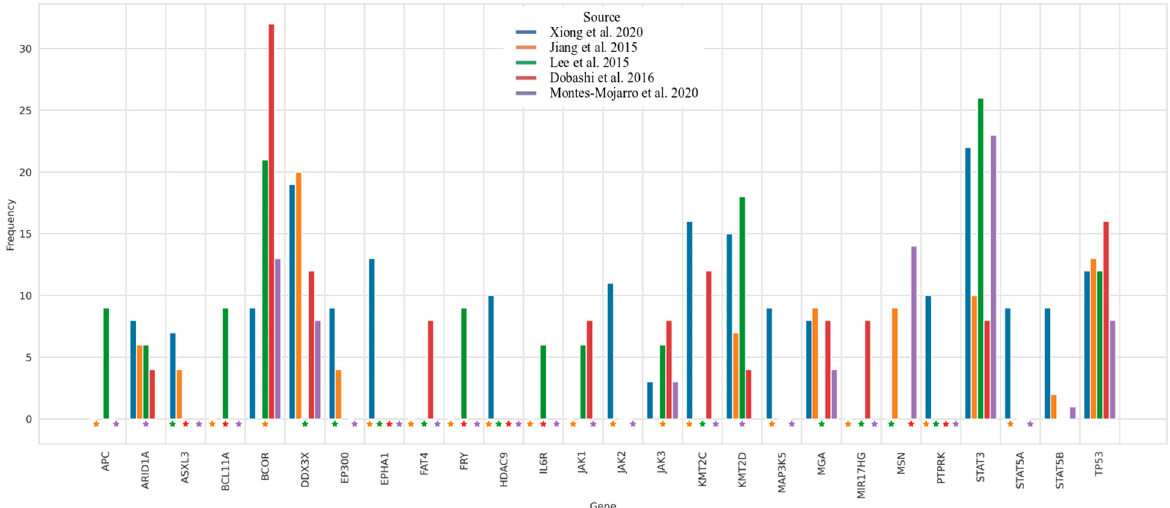
Figure 4. Representation of the genomic alteration frequencies of ENKTL according to the literature. Dataset comes from published data from Xiong et al. Cancer Cell 2020 ( n = 63 WES and 37 WGS), Jiang et al. Nature Genetics 2015 ( n = 25 WES and 80 targeted sequencing), Lee et al. Oncotarget 2015 ( n = 13 WES and 21 targeted sequencing), Dobashi et al. Genes Chromosomes Cancer 2016 ( n = 25 targeted sequencing), Montes-Mojarro et al. Modern Pathology 2020 (71 targeted sequencing). The top 10 most altered genes contained in each publication have been selected. Stars indicate missing genes in targeted panels.